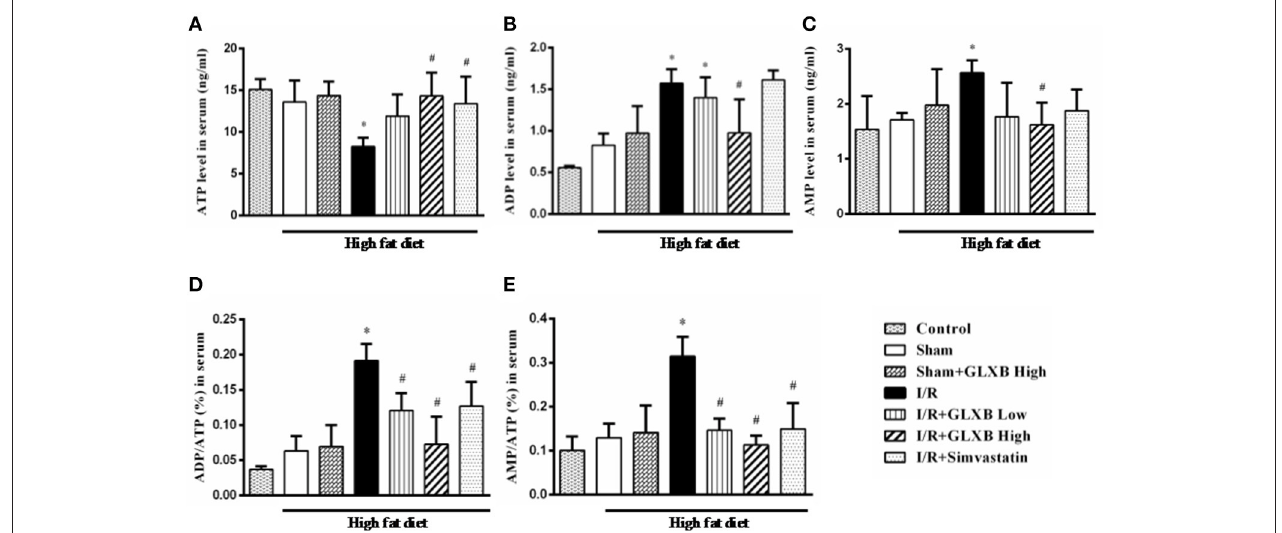
FIGURE 5 | The effect of GLXB on serum level of AMP, ADP, and ATP in rats. (A) The serum levels of ATP in different groups. (B) The serum levels of ADP in different groups. (C) The serum levels of AMP in different groups. (D) The ratio of ADP/ATP in serum in different groups. (E) The ratio of AMP/ATP in serum in different groups. Data are mean ± SEM, n = 6. * P < 0.05 vs. Sham group, # P < 0.05 vs. I/R group.